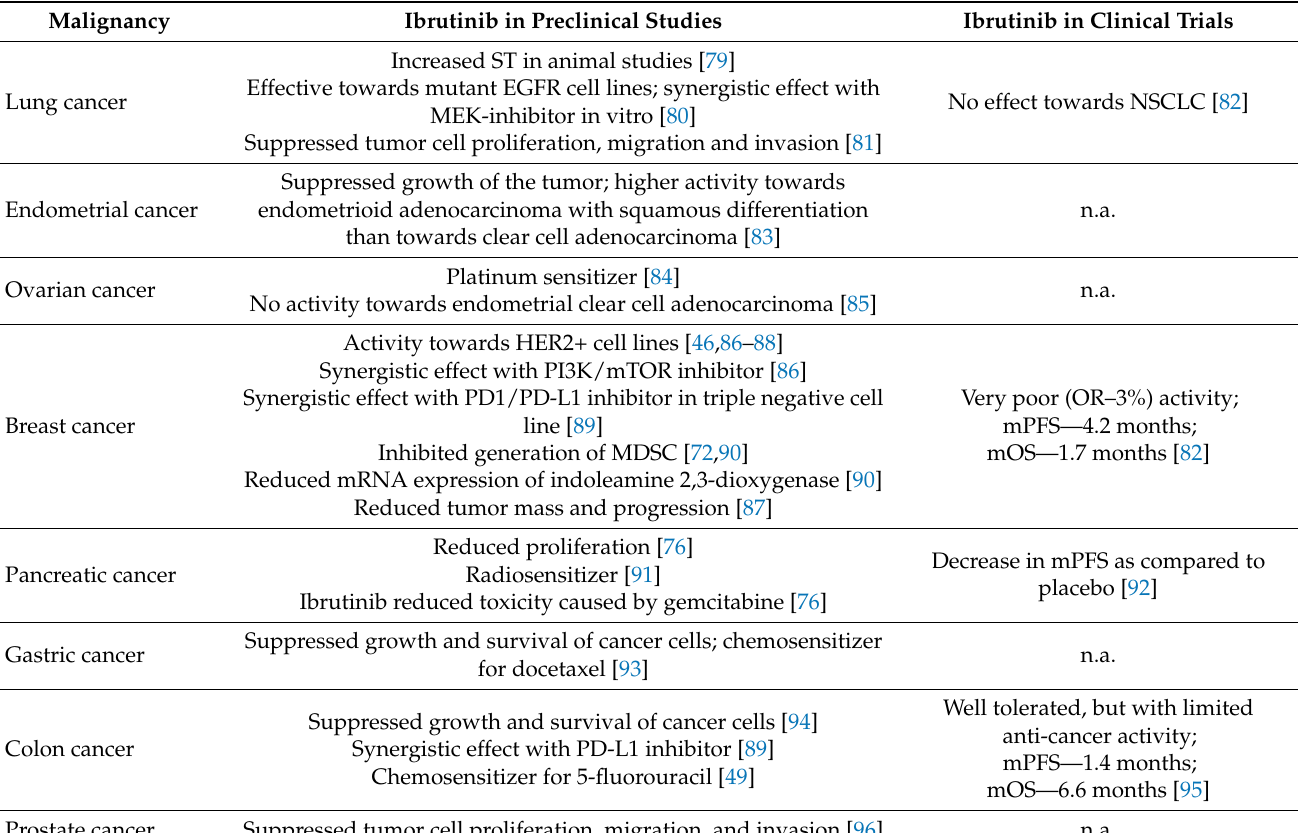
Table 2. Ibrutinib in studies: tumor specific